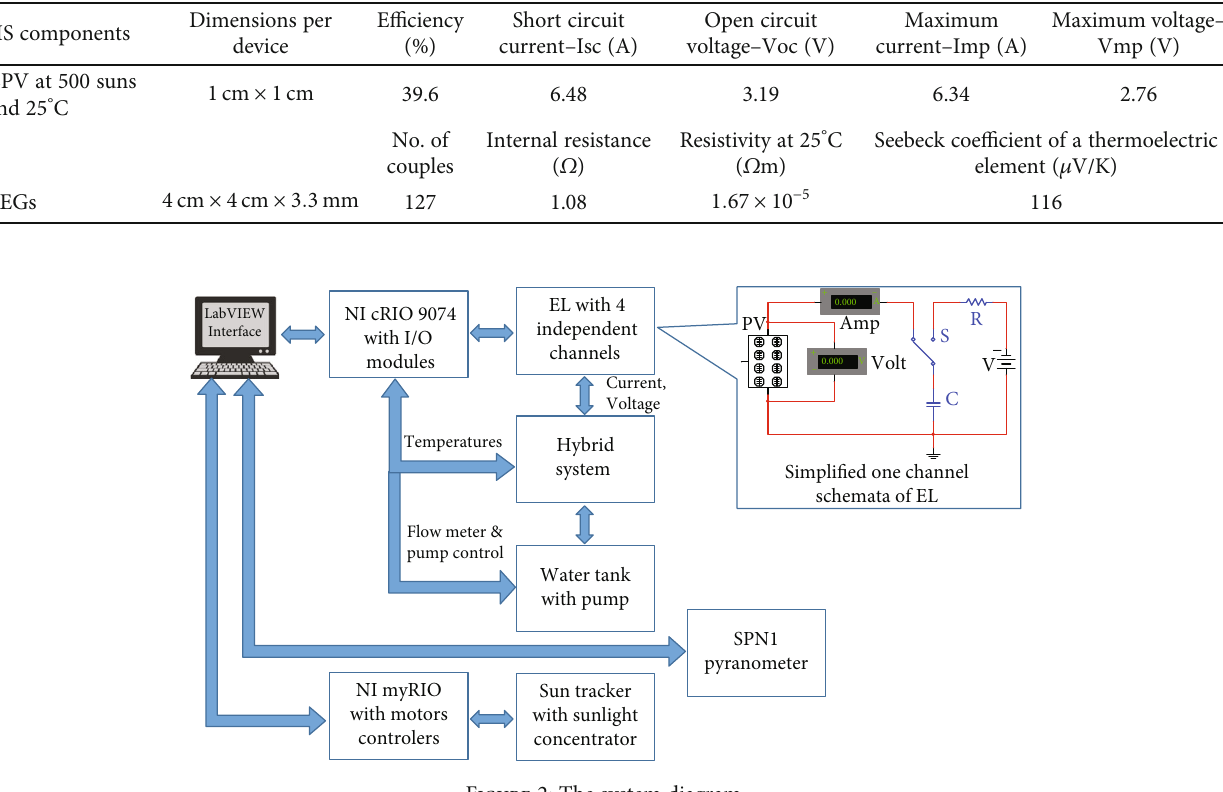
Figure 2: The system